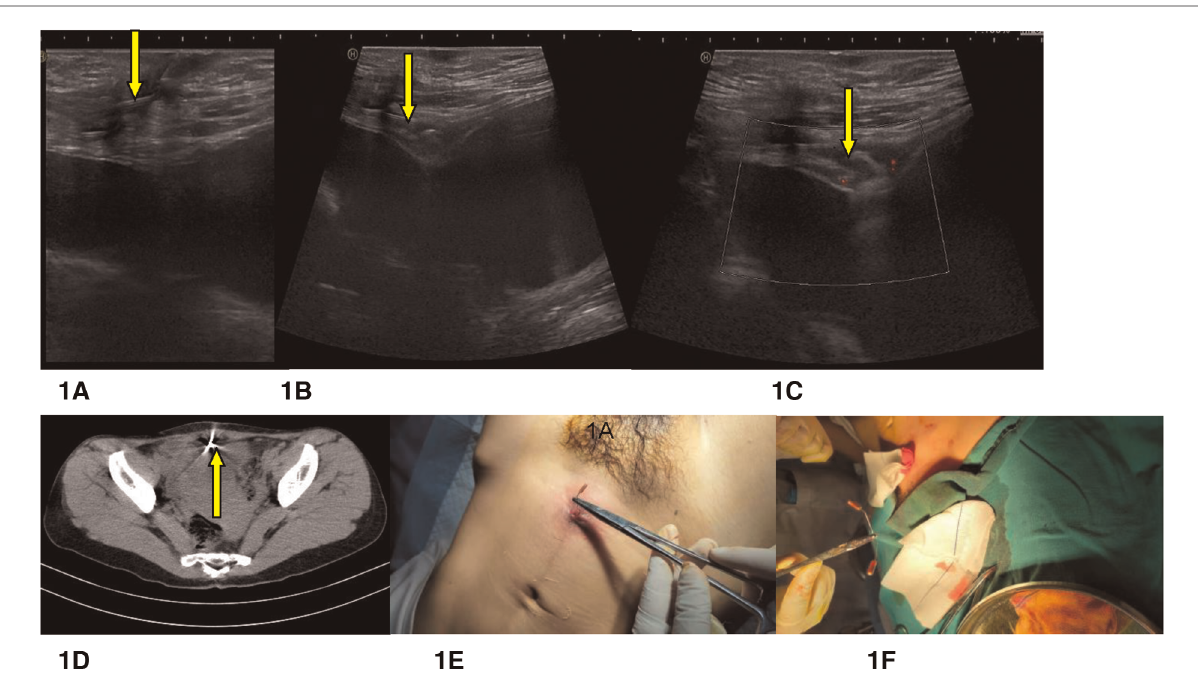
FIGURE 1 A 34-year-old woman presented with an abscess of the abdominal wall around the IUD, which had been discharging pus for 10 days. Yellow arrows indicate the IUD. ( A ) In this longitudinal section of the lower abdominal wall, linear hyperechoes (IUD) can be seen, folding the rectus abdominis through the center of the cesarean scar. ( B ) In this cross-section of the inferior abdominal wall, linear hyperechoes (IUD) can be seen, clasping the straight muscle of the abdomen through the center of the cesarean scar. ( C ) In this cross-section of the lower abdominal wall, abscess echoes can be seen in front of the anterior wall of the bladder, and dotted blood fl ow signals can be seen surrounding them. ( D ) CT cross-section of the inferior abdomen. A V-shaped metal IUD can be seen on the lower abdominal wall. ( E ) Part of the IUD was removed from the lower abdominal wall during the operation. ( F ) The MCu-IUD was extracted from the inferior abdominal wall during the operation.IUD: intrauterine